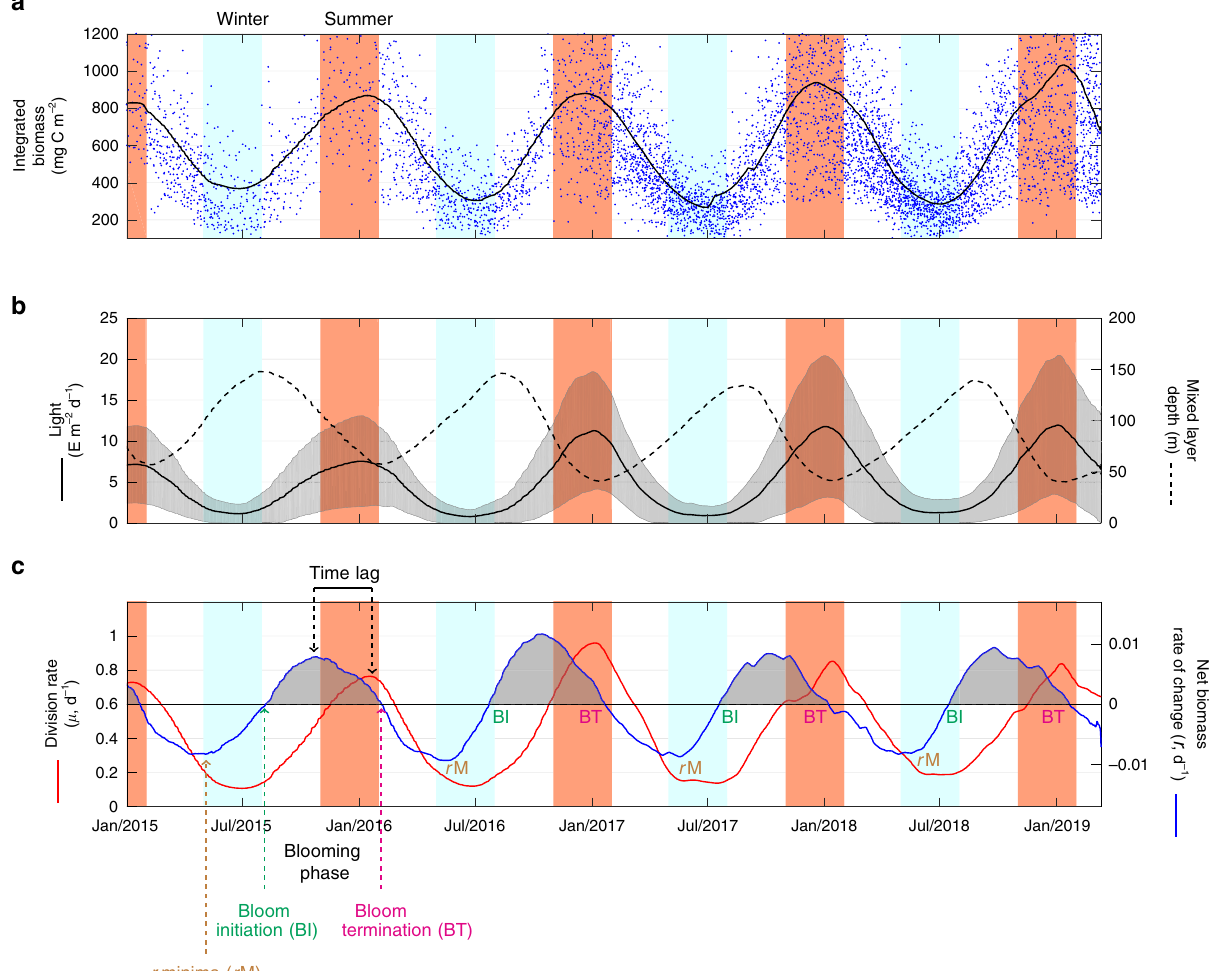
Fig. 1 Annual cycles of phytoplankton biomass in the Southern Ocean. a Annual cycles of phytoplankton carbon integrated from surface to the depth of the mixed layer or euphotic depth (whichever is deeper). Blue dots: Individual fl oat observations. Continuous black line: Average time series of phytoplankton carbon from individual fl oat-based observations for the Southern Ocean. b Black continuous line: Average time series of the mean light level in the surface mixed layer in the Southern Ocean computed as photosynthetically active radiation (PAR) (shaded area represents the standard deviation). Black dashed line: Average time series of the depth of the surface mixed layer. c Red continuous line: Average time series of phytoplankton division rates ( μ ). Blue continuous line: Average time series of phytoplankton net biomass rate of change rate ( r ). The phytoplankton blooming phase is de fi ned as the time period where r > 0 (gray shaded area in ( c )), constrained between the time of `Bloom initiation' (BI) and `Bloom termination' (BT) of each annual cycle. The ` r minima' ( r M) point, indicates the moment in which autumn biomass starts to decline at a lower rate prior to the onset of the bloom. Seasonally, a clear `Time lag' exists between μ and r where the highest net biomass rates of change are observed ~3 months before the peak in division rates. Light blue and red shaded panels indicate austral winter (May – August) and summer (November – February) months, respectively. Averaged time series ( a – c ) are based on individual fl oat-based observations for the Southern Ocean. See “ Methods ” for details on the smoothing of time